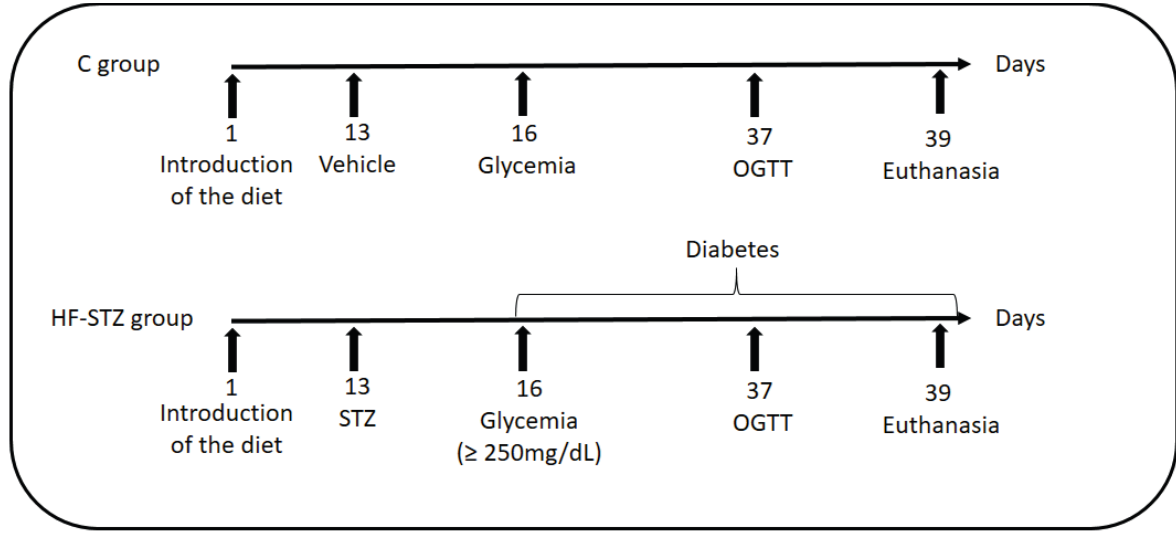
Figure 1 - experimental design Rats received an intraperitoneal (i.p.) injection of streptozotocin (STZ) or vehicle on the 13 th day of high-fat or control diets. After three days (on the 16 th day of treatment), the animals were subjected to glycemic tests. On the 37 th day, oral glucose tolerance tests were performed. On the 39 th day, the animals were sacrificed for